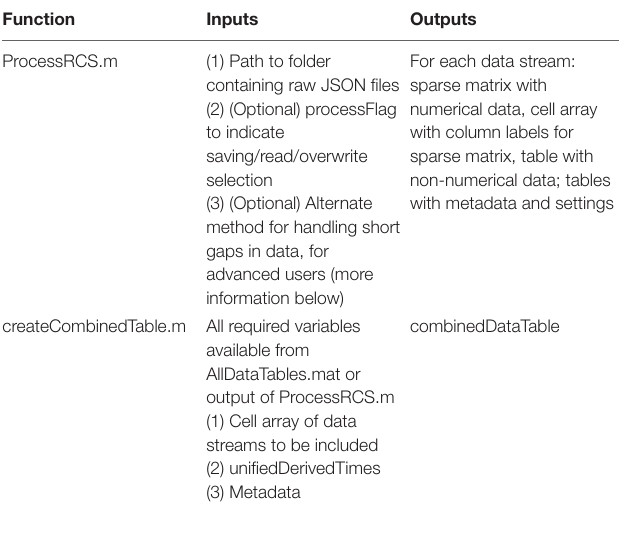
TABLE 3 | Description of functions for creating CombinedDataTable. Function